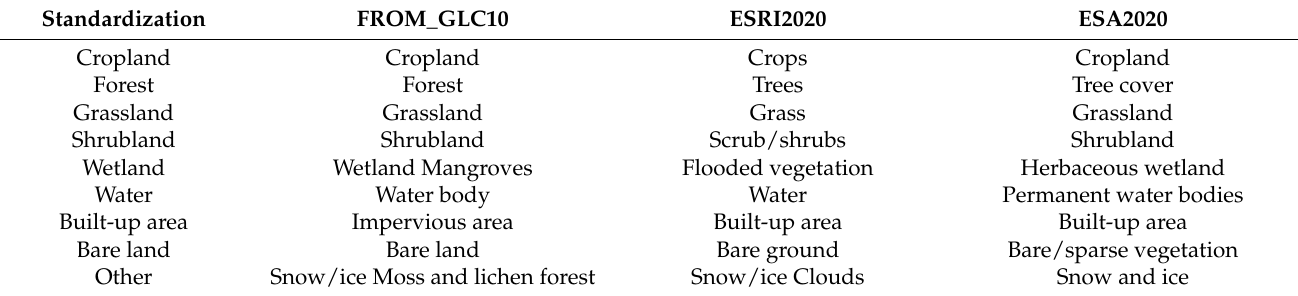
Table 4. Classification standardization of the three land cover products.